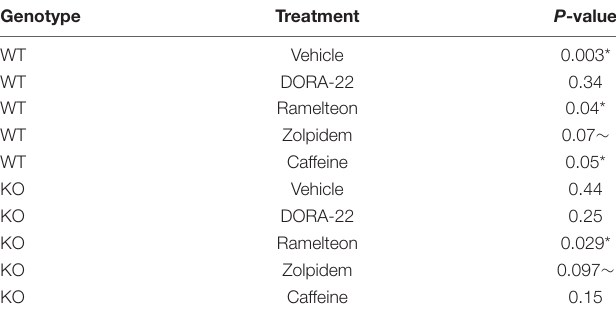
TABLE 3 | Preference for social novelty: paired t -test results.